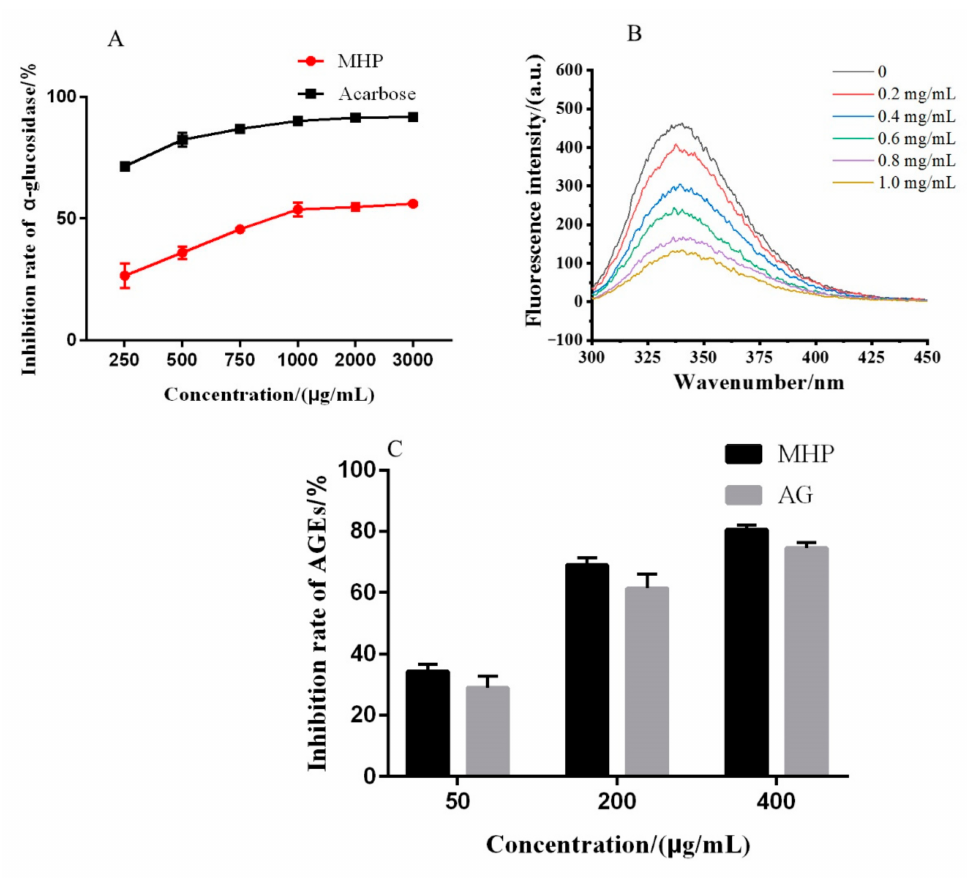
Figure 5. α -glucose inhibitory activity ( A ), the quenching effect of polysaccharides on fluorescence spectra of α -glucosidase ( B ) and effect of polysaccharides on the formation of fluorescent AGEs ( C